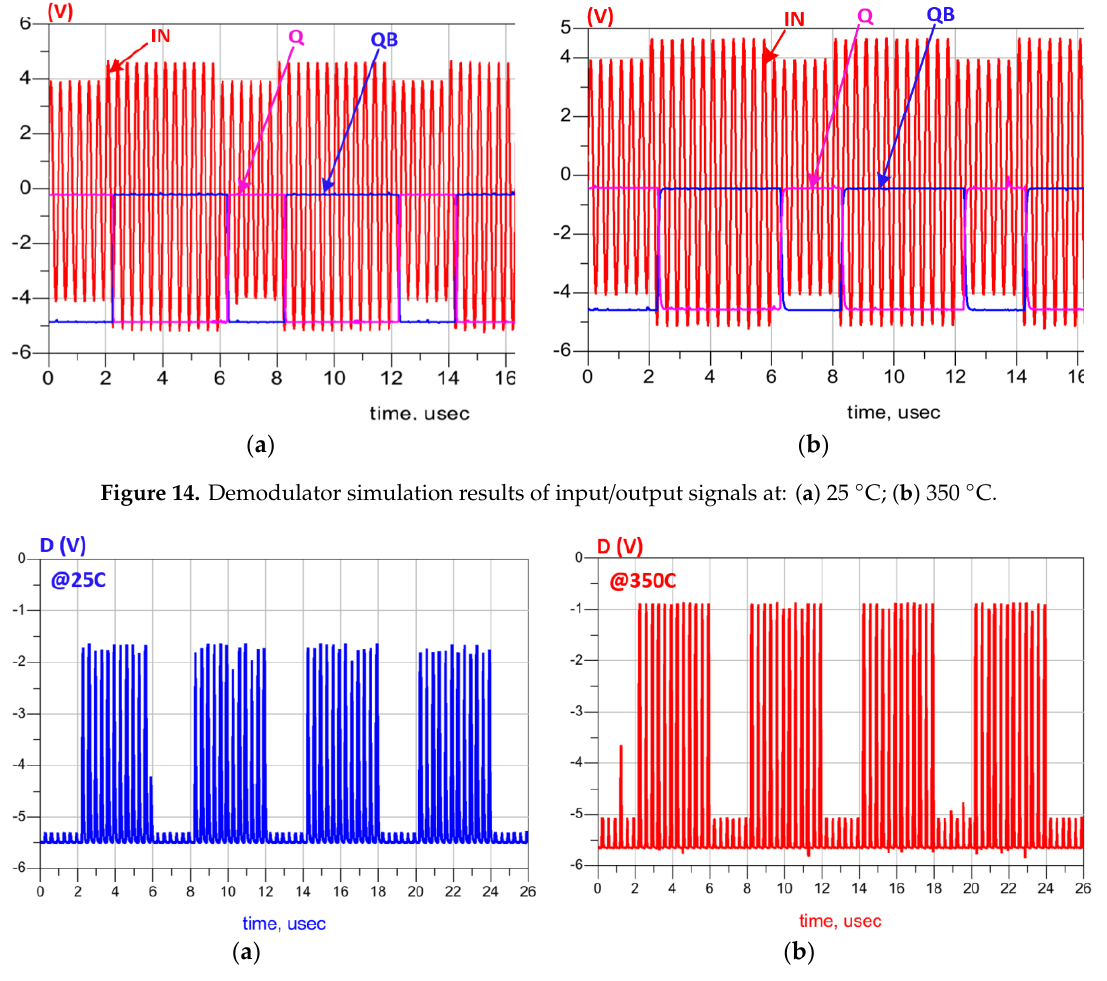
Figure 15. Impact of the temperature on detected data (D) at: ( a ) 25 °C; ( b ) 350 °C.